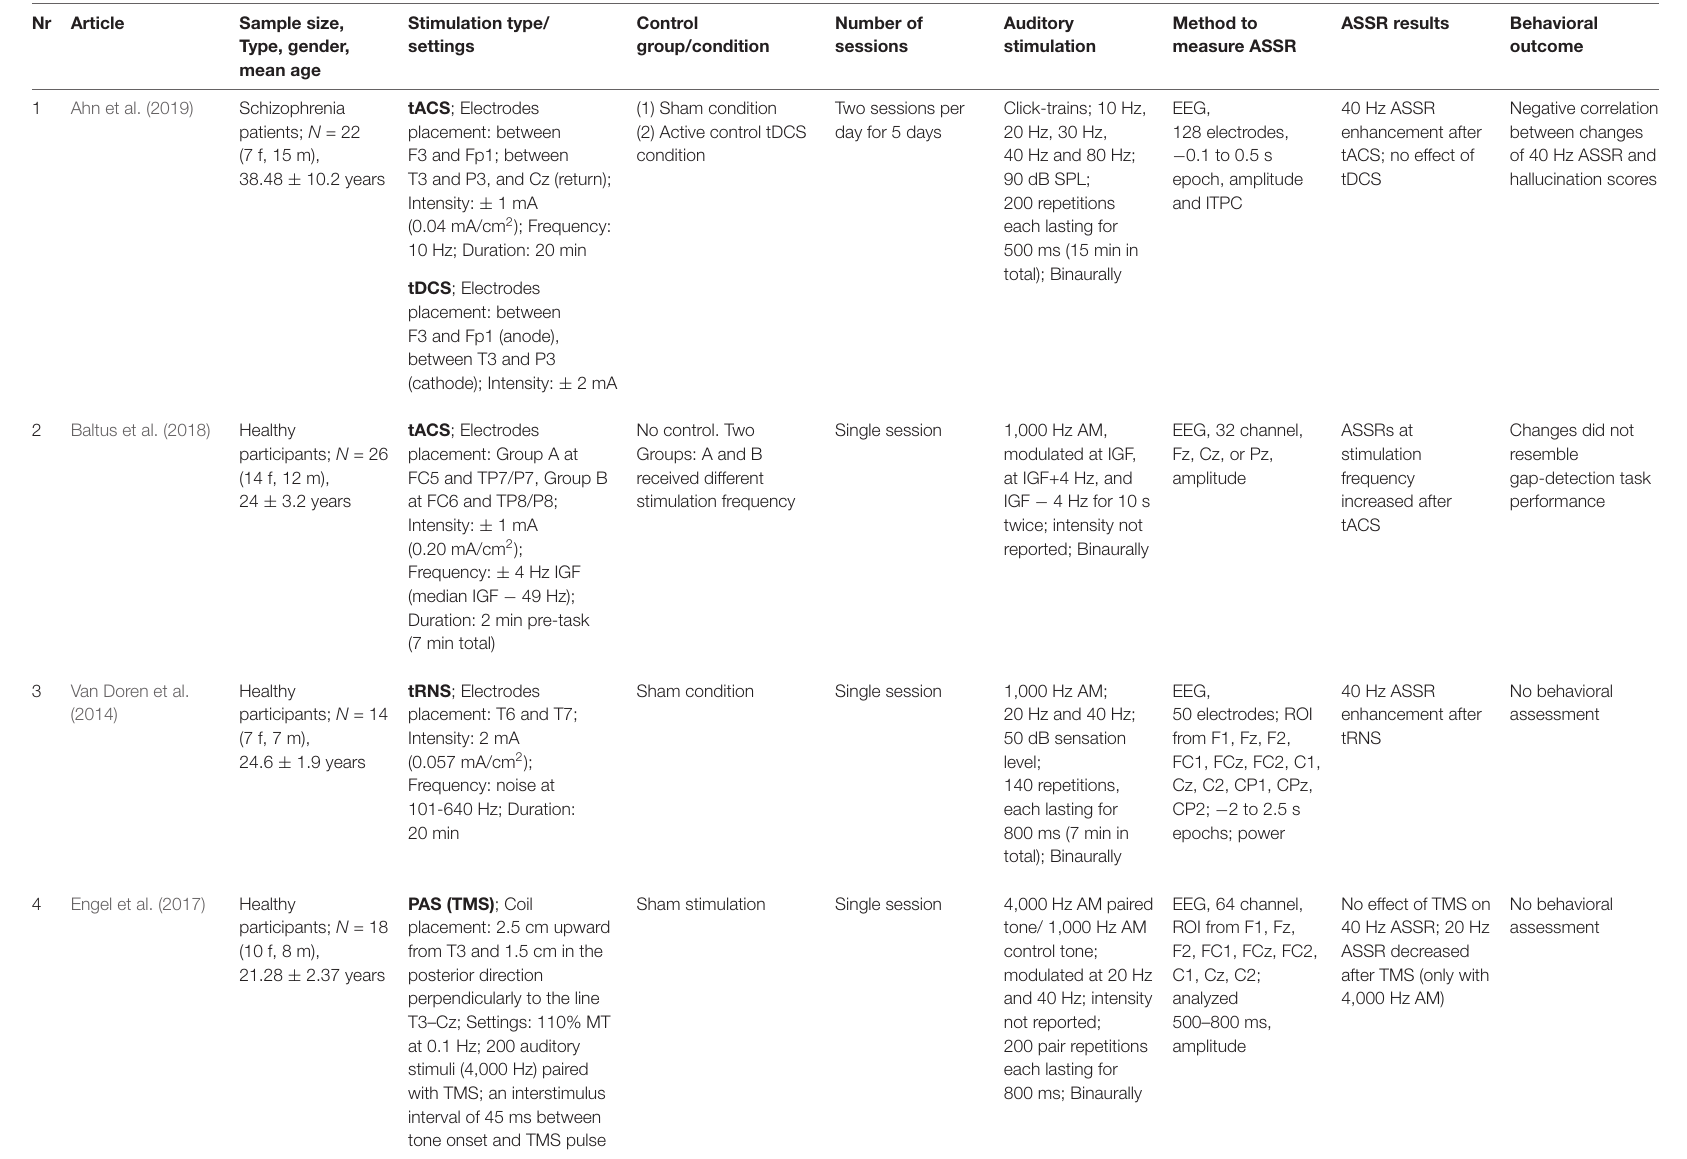
TABLE 1 | Summary of brain stimulation effects on auditory steady-state responses and methodological descriptions for the included